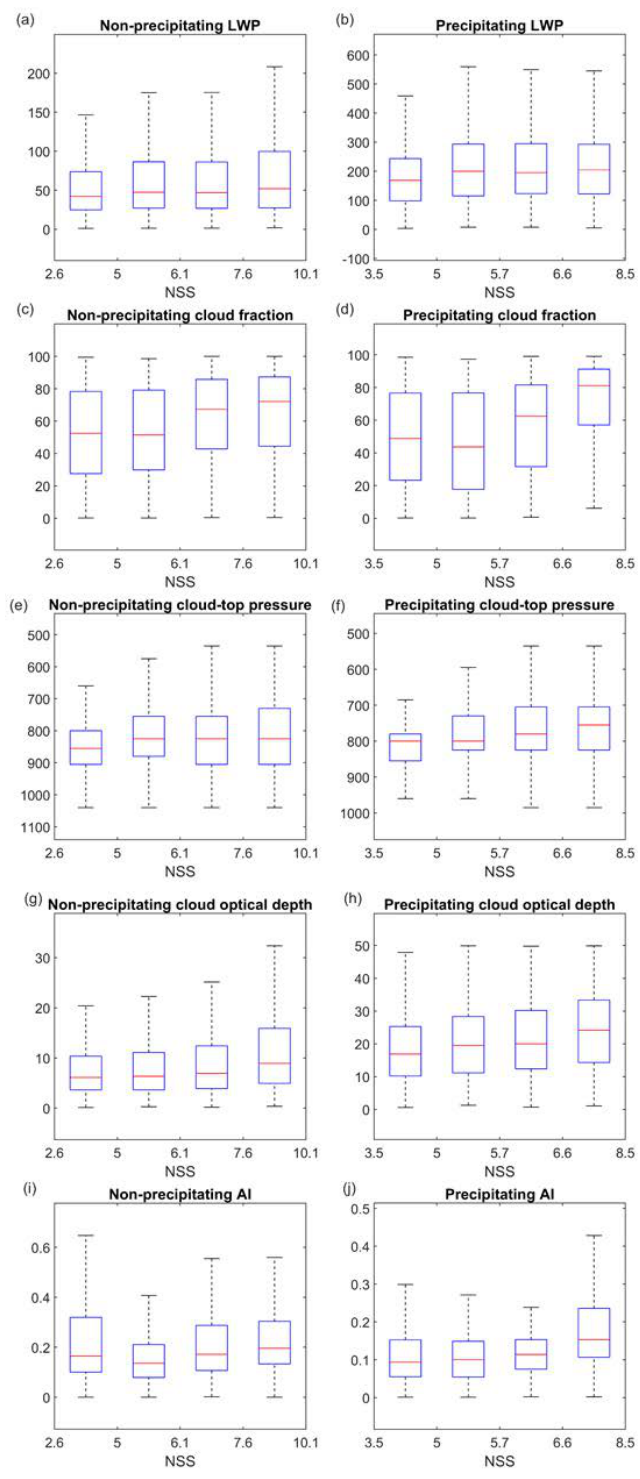
Figure 6. The boxplot of LWP (unit:gm − 2 ), cloud fraction (unit: %), cloud top pressure (unit: hPa), cloud optical depth, and AI in each NSS bin. The numbers on the x-axis denote 10th, 30th, 50th, 70th, and 90th percentiles by sequence. ( a , c , e , g , i ) For non-precipitating clouds. ( b , d , f , h , j ) For precipitating clouds. The median of each dataset is shown in red; the lower quartile (25th percentile, or Q 1 ) and the upper quartile (75th percentile, or Q 3 ) are shown as the lower and upper boundary of the blue box,